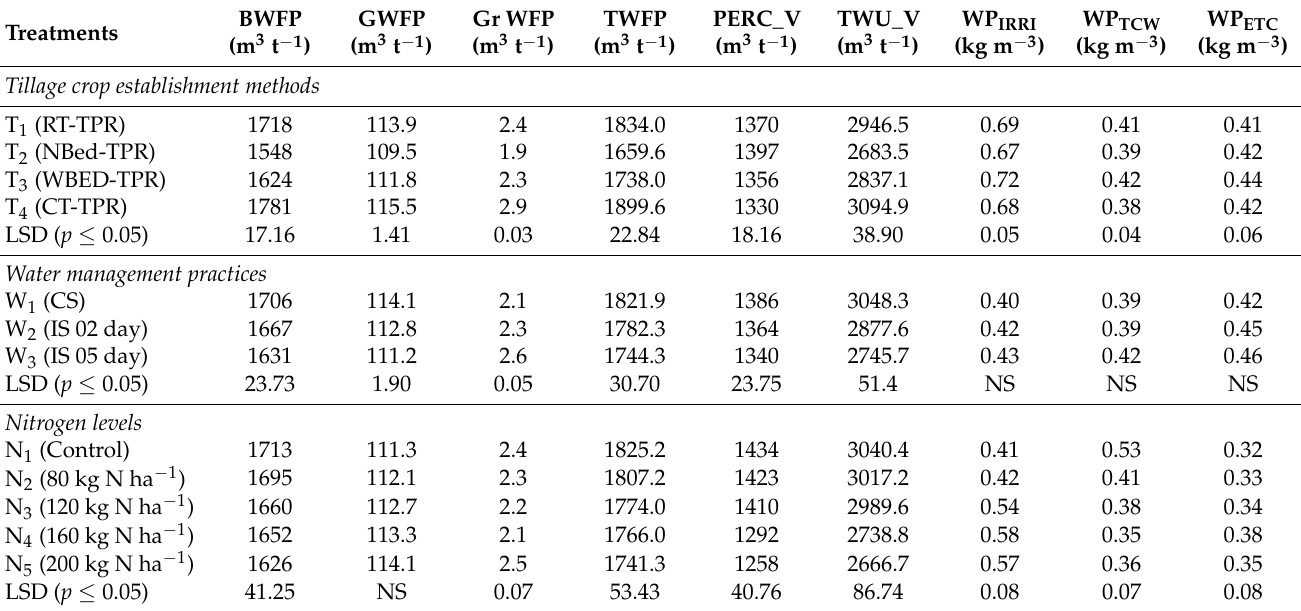
Table 2. The impact of various treatments on footprints and productivity of applied irrigation water in 2017